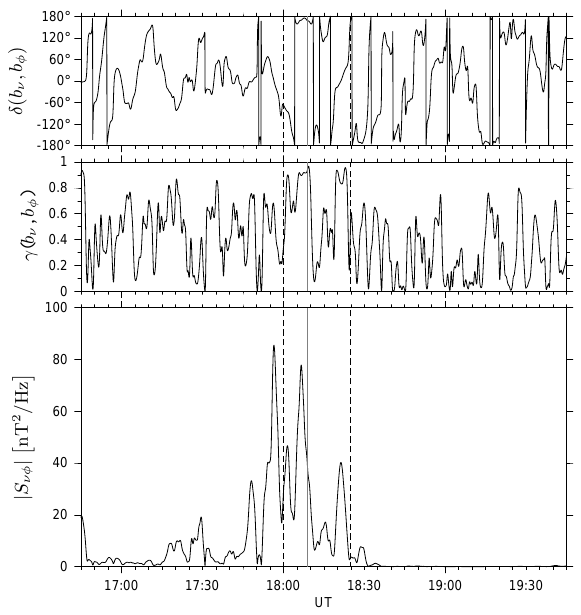
Fig. 5: Instantaneous amplitude and phase of the ( b ν , b φ ) Fig. 5. Instantaneous amplitude and phase of the ( b ν , b φ ) cross- cross-power spectral density averaged over the Pi2 band power spectral density averaged over the Pi2 band on on C3.